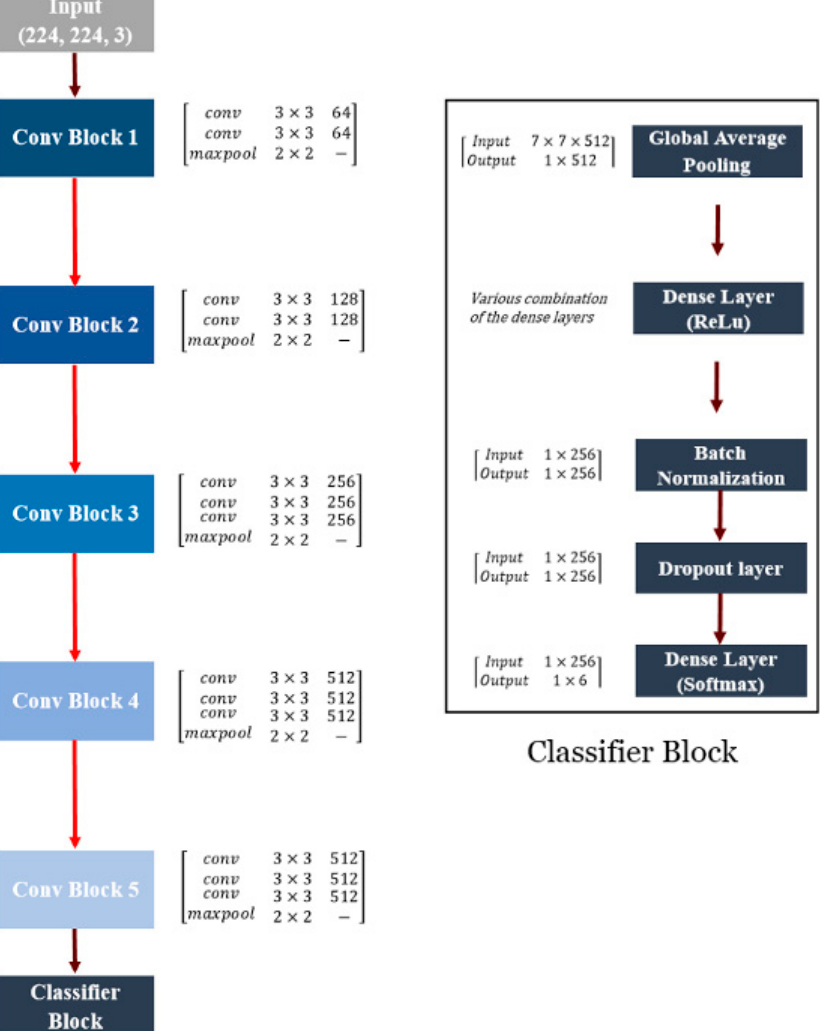
Figure 2. Schematic of VGG-16 architecture (left panel) and classifier block structure (right panel) evaluated in the current research.